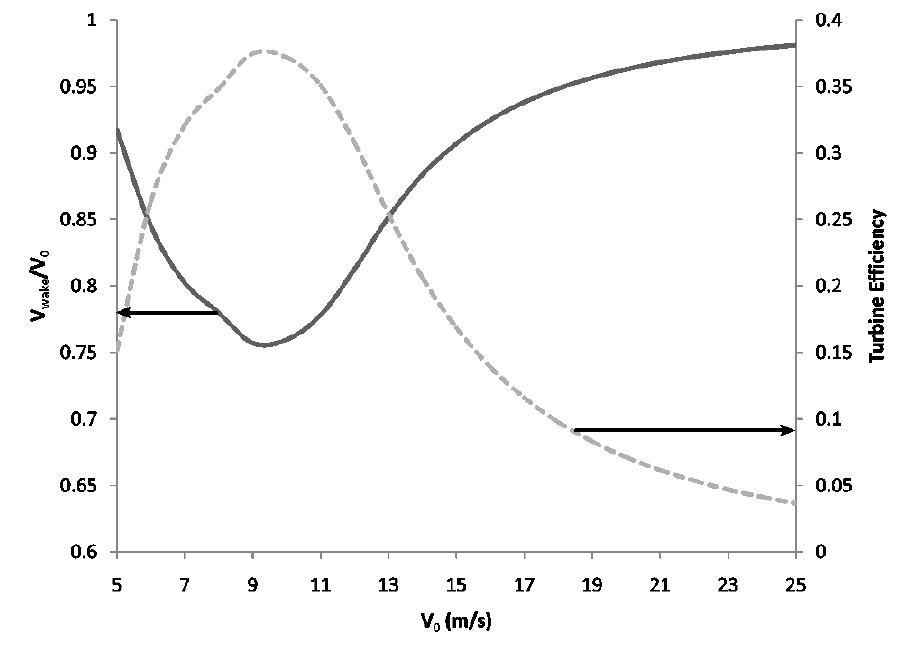
Figure 8. Change in wake velocity as a function of incoming velocity overlapped with turbine